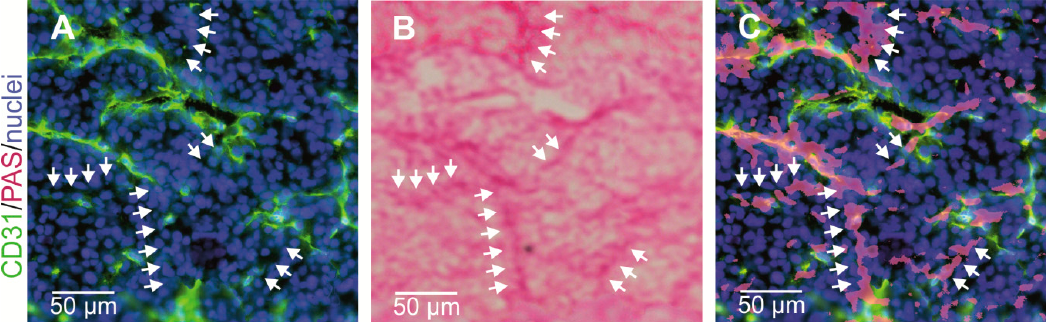
Figure 4. Vasculogenic mimicry of cancer cells lining tumor vessels. CD31-negative/PAS-positive VM channels in a HT1080 xenograft mouse tumor model were visualized by consecutive immunostaining and histochemical staining of the same cryosection: ( A , C ) normal CD31-positive blood vessels are labeled in green; and ( B , C ) CD31-negative VM channels are detectable by PAS staining. Nuclei are stained blue. ( A ) Cryosections were first immunostained and photographed; ( B ) subsequently, histochemically PAS-stained and photographed again; and ( C ) then the images were overlaid to demonstrate numerous CD31-negative/periodic acid Schiff (PAS)-positive VM channels (arrows). Representative images are shown.